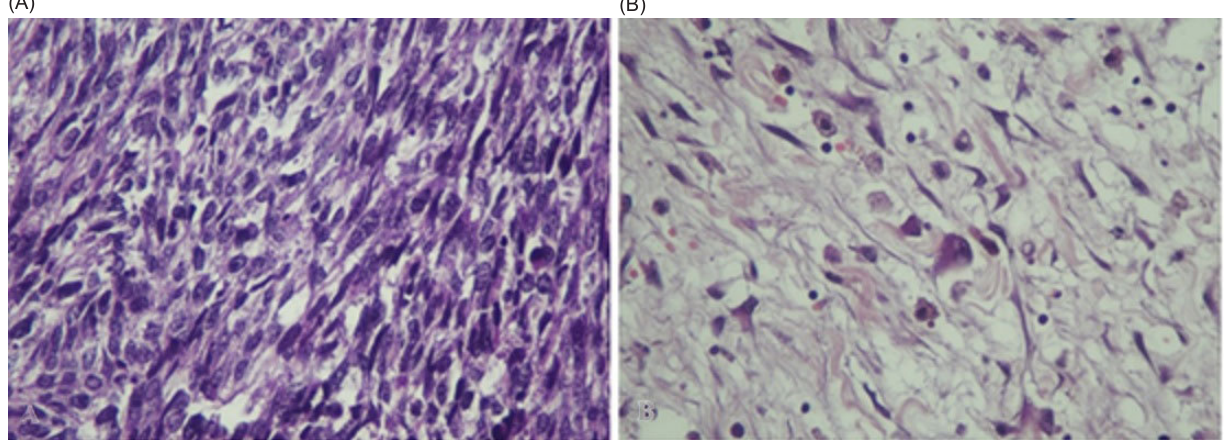
Figure 2: (A) H&E section from tumor show malignant spindle cells with hyperchromatic nuclei. (B) H&E section show some atypical spindle and round cells with abundant eosinophilic cytoplasm (Rhabdomyolysis